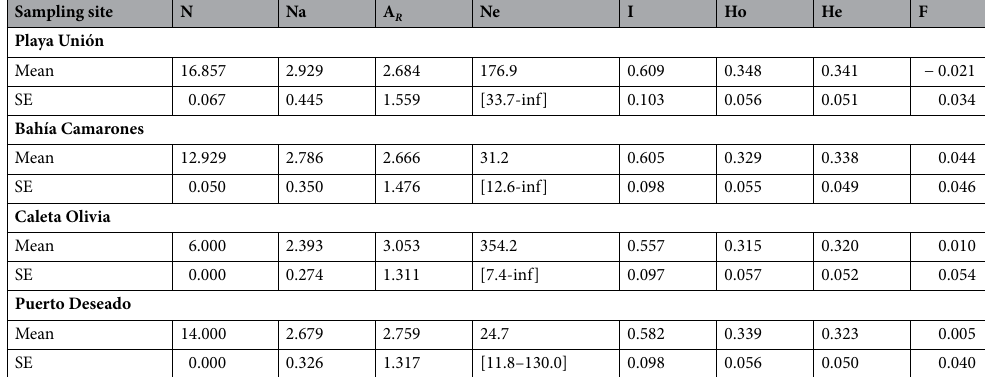
Table 4. Summary statistics of Commerson’s dolphin ( Cephalorhynchus commersonii ) for 28 microsatellites loci by sampling site. N = Sample Size, Na = Number of Alleles, AR = Allelic Richness (based on min. sample size of 7 diploid individuals), Ne = Effective population size, I = Information Index, Ho = Observed Heterozygosity, He = Expected, and F = Fixation Index. Mean and standard deviation (SD) are reported, except for Ne where the 95% confidence interval [CI] is displayed.